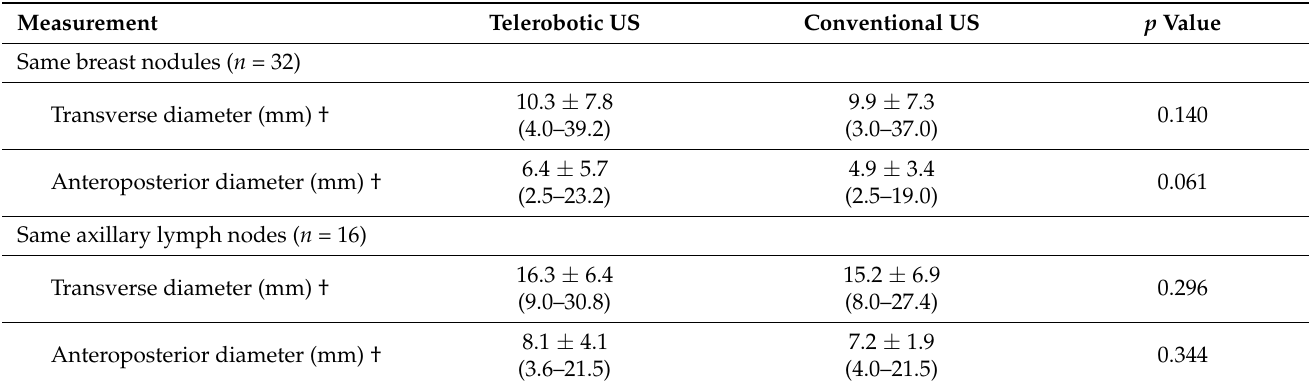
Table 4. Measurements of the same breast nodules and axillary lymph nodes detected by 5G-based telerobotic and conventional US examinations in Scenario A. † Data are means ± standard deviation, with ranges in parentheses. Abbreviation: US,